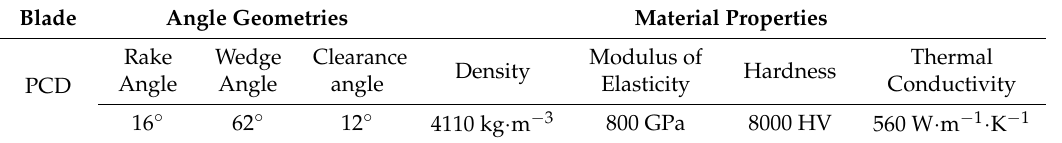
Table 1. Material parameters of the PCD (polycrystalline diamond) blades used in this work.